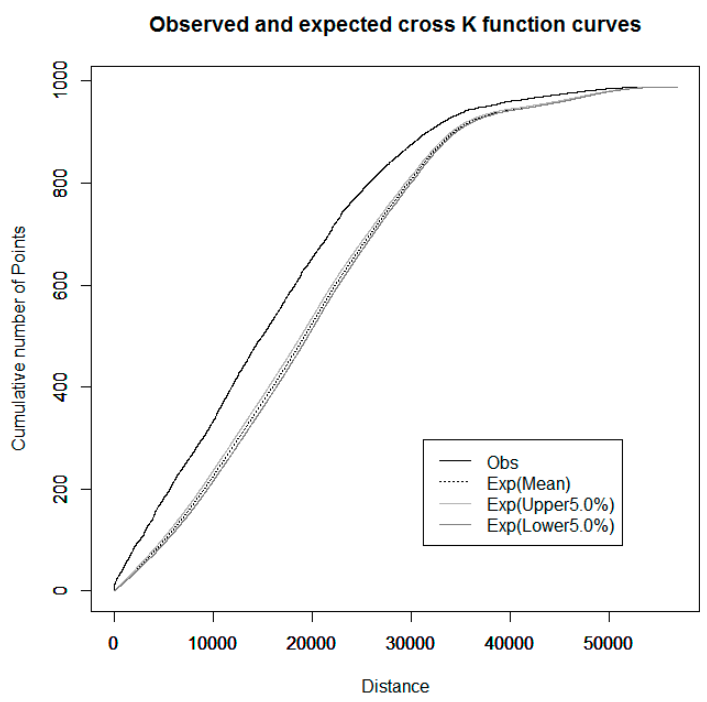
Figure 6. Results of the network cross K-function analysis between land-use change and flood damage.